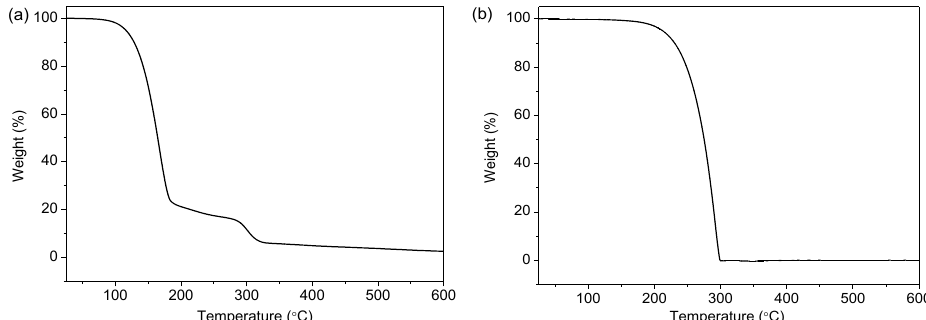
Figure 2. TGA curves of ( a ) n -hexadecane- and ( b ) n -eicosane-encapsulated capsules at a heating rate of 10 °C min -1 in nitrogen flow.